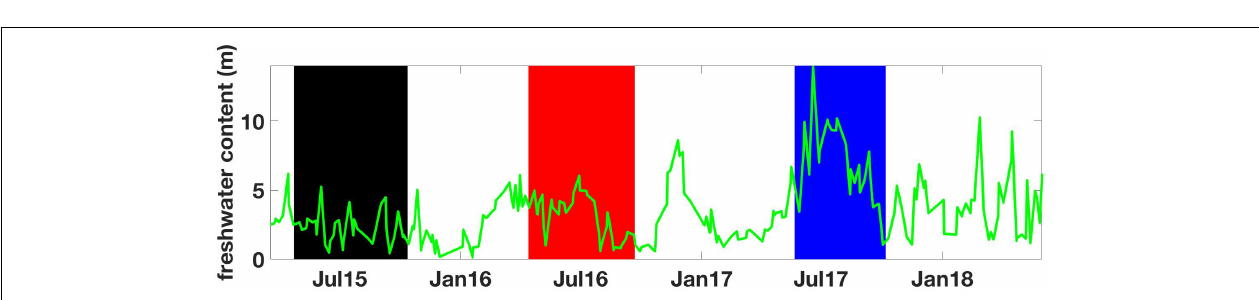
FIGURE 7 | Top row is the integrated rate of energy transfer (J m − 2 ; bars) over the duration of wind events observed between the spring and fall transitions ( Supplementary Figure S5 ) in 2015 (left) , 2016 (middle) , and 2017 (right) . The width of the bars equates to the duration of the wind event. The top panels also show the potential energy needed to mix the upper water column (surface to 10 m in black, surface to 20 m in gray). Lower panel is surface water pCO 2 from QIFS (black) and the depth of the 21 kg m − 3 density anomaly ( σ t ) surface.